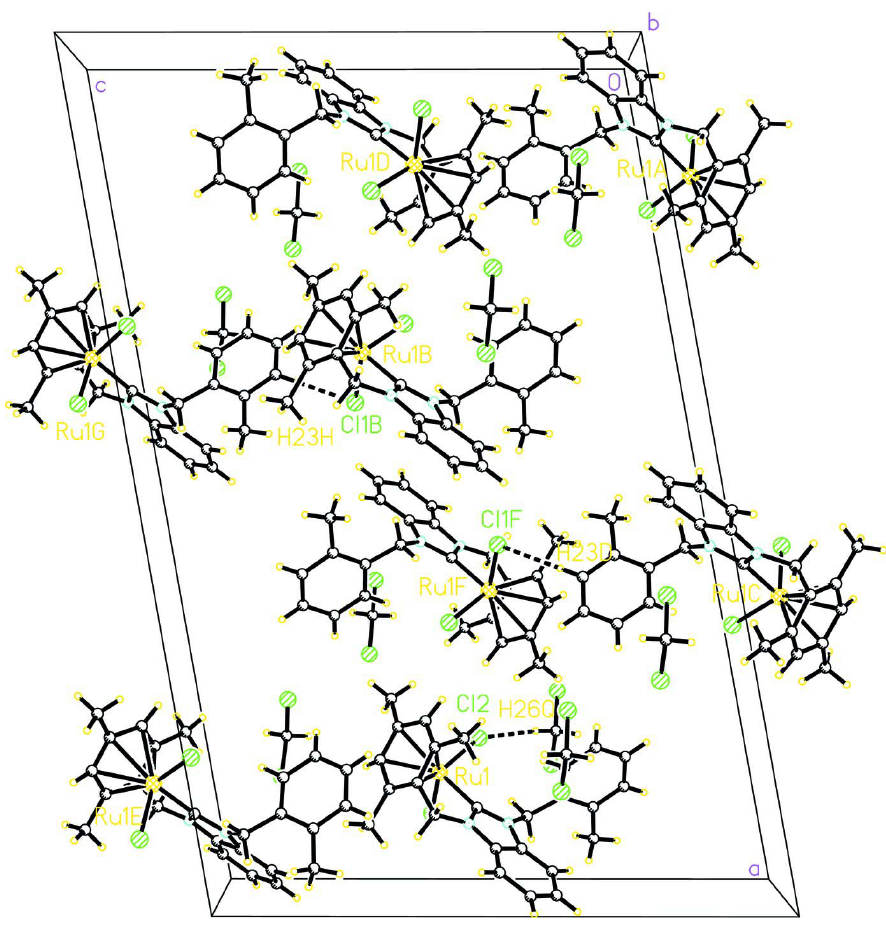
Figure 2 A packing diagram for (I). [Symmetry codes: A = 1 - x, y, 0.5 - z ; B = - 1/2 + x, 1/2 + y, z ; C = 1.5 - x, 1/2 + y, 0.5 - z ; D =